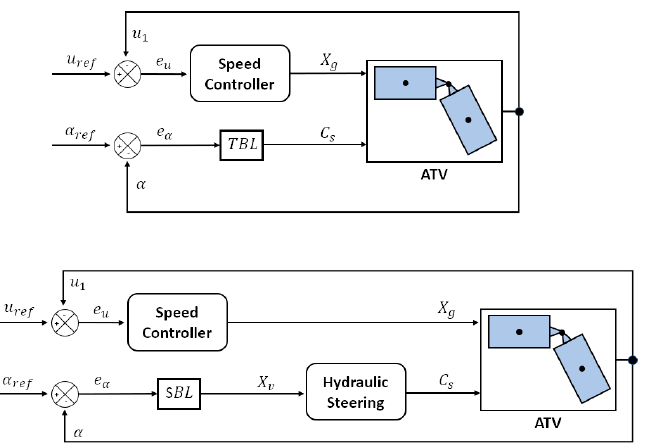
Figure 14. Simplified schematic of the Torque-Based Logic (TBL) and Speed-Based Logic (SBL) applied to the ATV non-linear model.